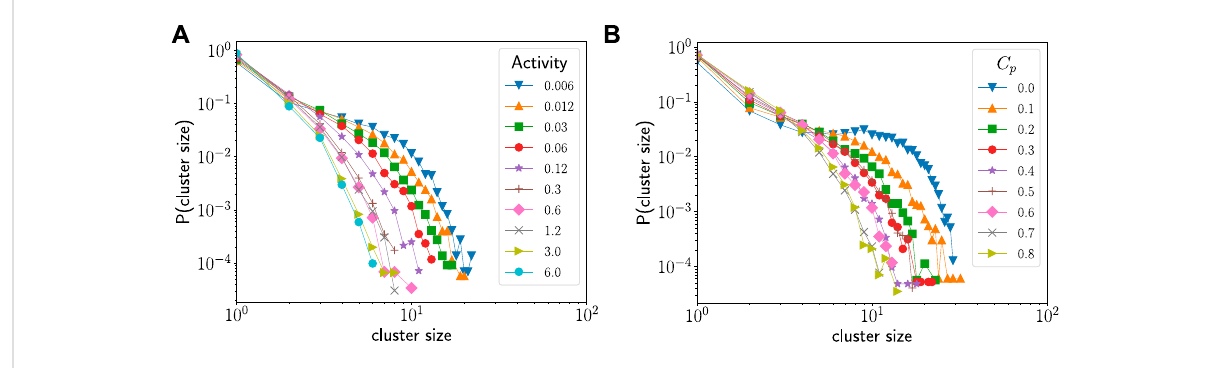
FIGURE 4 (A) Stability phase diagram for the vesicle without activity. Spherical morphology is unstable in the high C p and high ψ st regime (dark blue). The dashed line marks the case of ψ st = 0.1, where the spherical shape of the vesicle is stable for the range of spontaneous curvature values considered here. (B,C) Thestabilitydiagraminthepresenceofactivityin (cid:1) C p – γ planefortwovalues of (cid:1) λ 2 . (D – F) Thestabilitydiagraminthepresenceofactivityin (cid:1) λ – γ plane for two values of (cid:1) C p . The values of all other parameters are as shown in Table 2